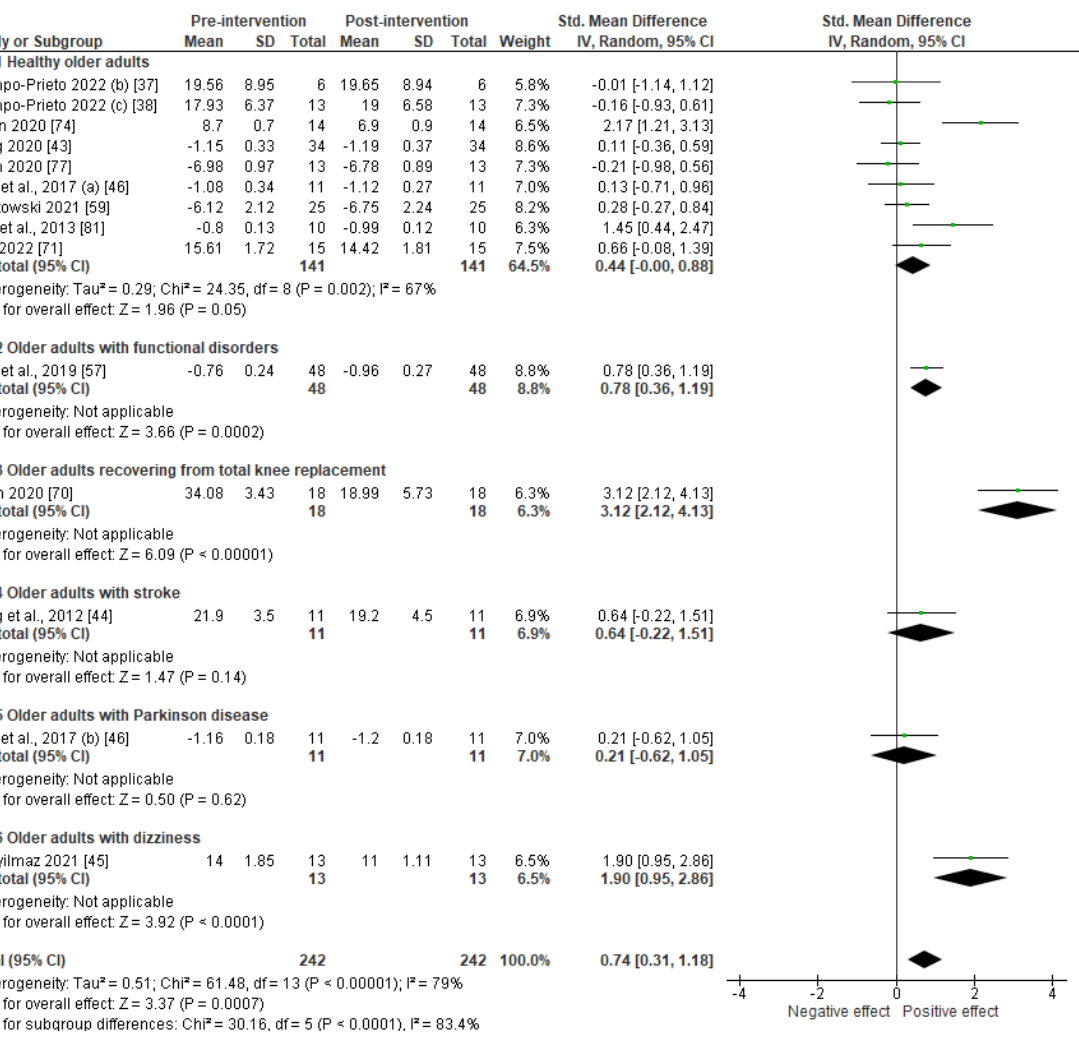
Figure A1. Forest-plot of effects of interventions using immersive technologies on gait speed — subgroup analyses to observe the influence of pathology.